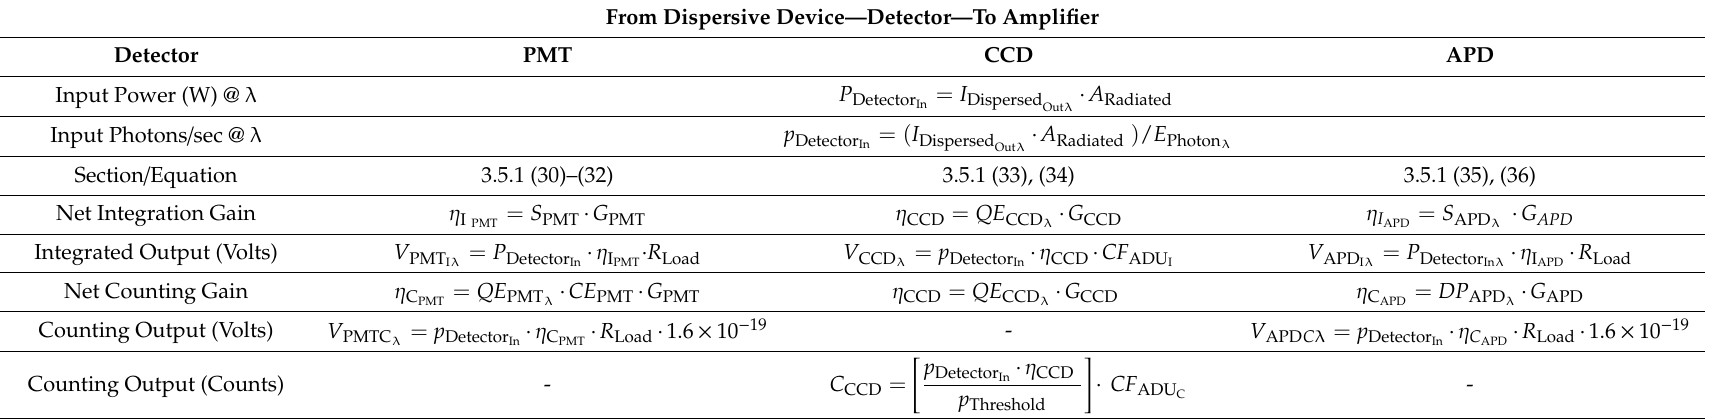
Table 6. Summary of intensity transfer function through